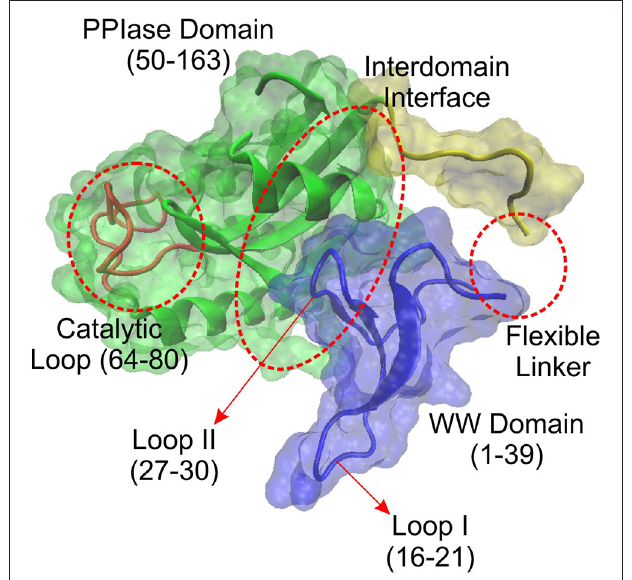
FIGURE 2 | Molecular structure of human Pin1 (PDB: 1PIN) without ligand binding. Pin1 is predominantly made up of two major domains: WW domain and PPIase domain. Within the WW domain, there exist two loops, namely Loop I and II. As for the PPIase domain, there is a catalytic loop at the catalytic site. There also exists PPIase binding domain where it could bind to the pS/T-P motif apart from the WW domain. In addition, existing between the two domains, there lies an interdomain interface that has been found to be important in Pin1 allosteric regulation.